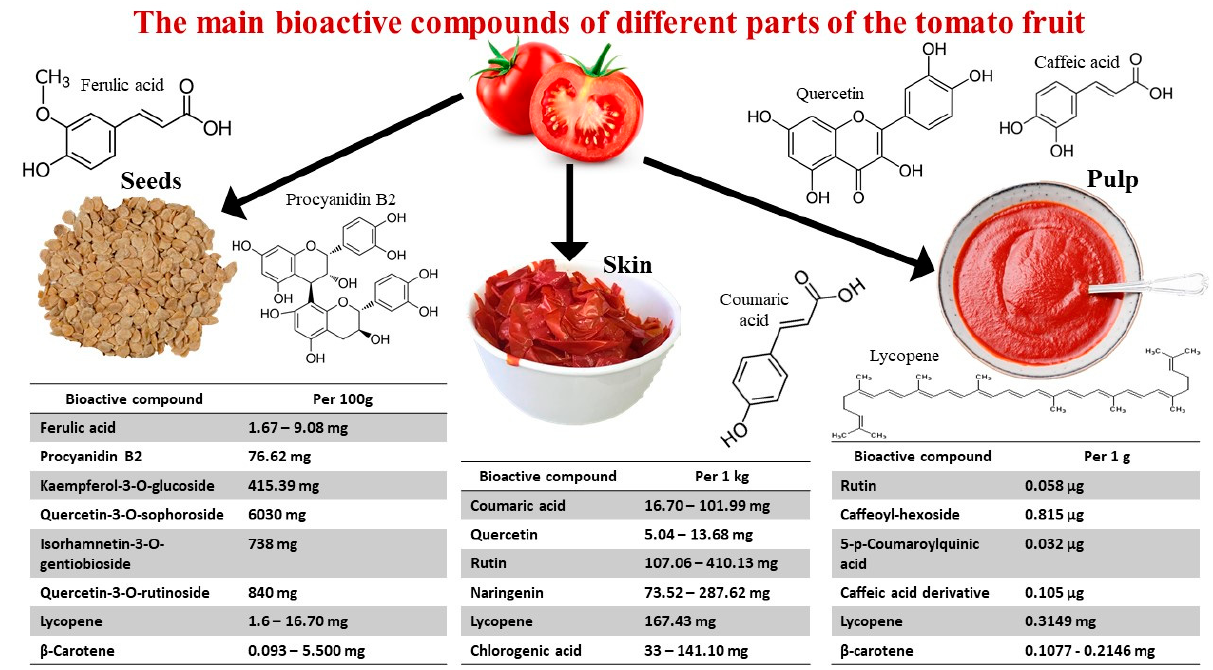
Figure 2. Main bioactive compounds of different tomato fruit parts, namely, seeds, skin/peel and pulp. Quantitative data adapted from Kumar et al. [80].